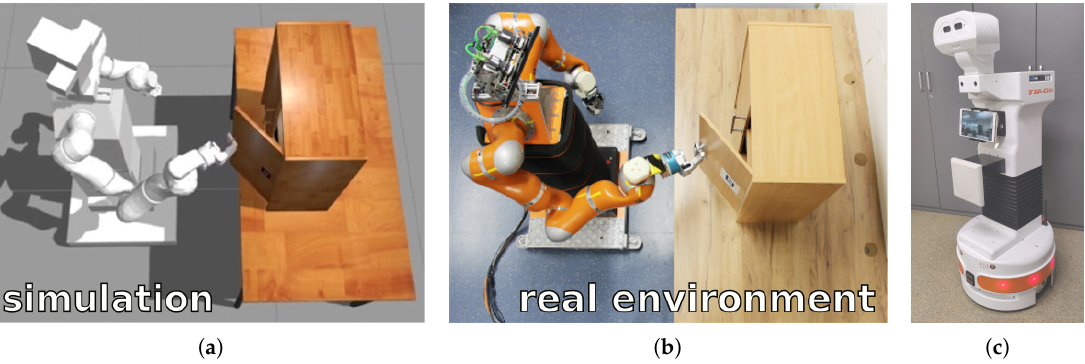
Velma service robot presenting an exemplary skill [16]—opening a cabinet door: ( a ) simulation, ( b ) reality, ( c ) Rico–TIAGo social robot with RFID antenna and